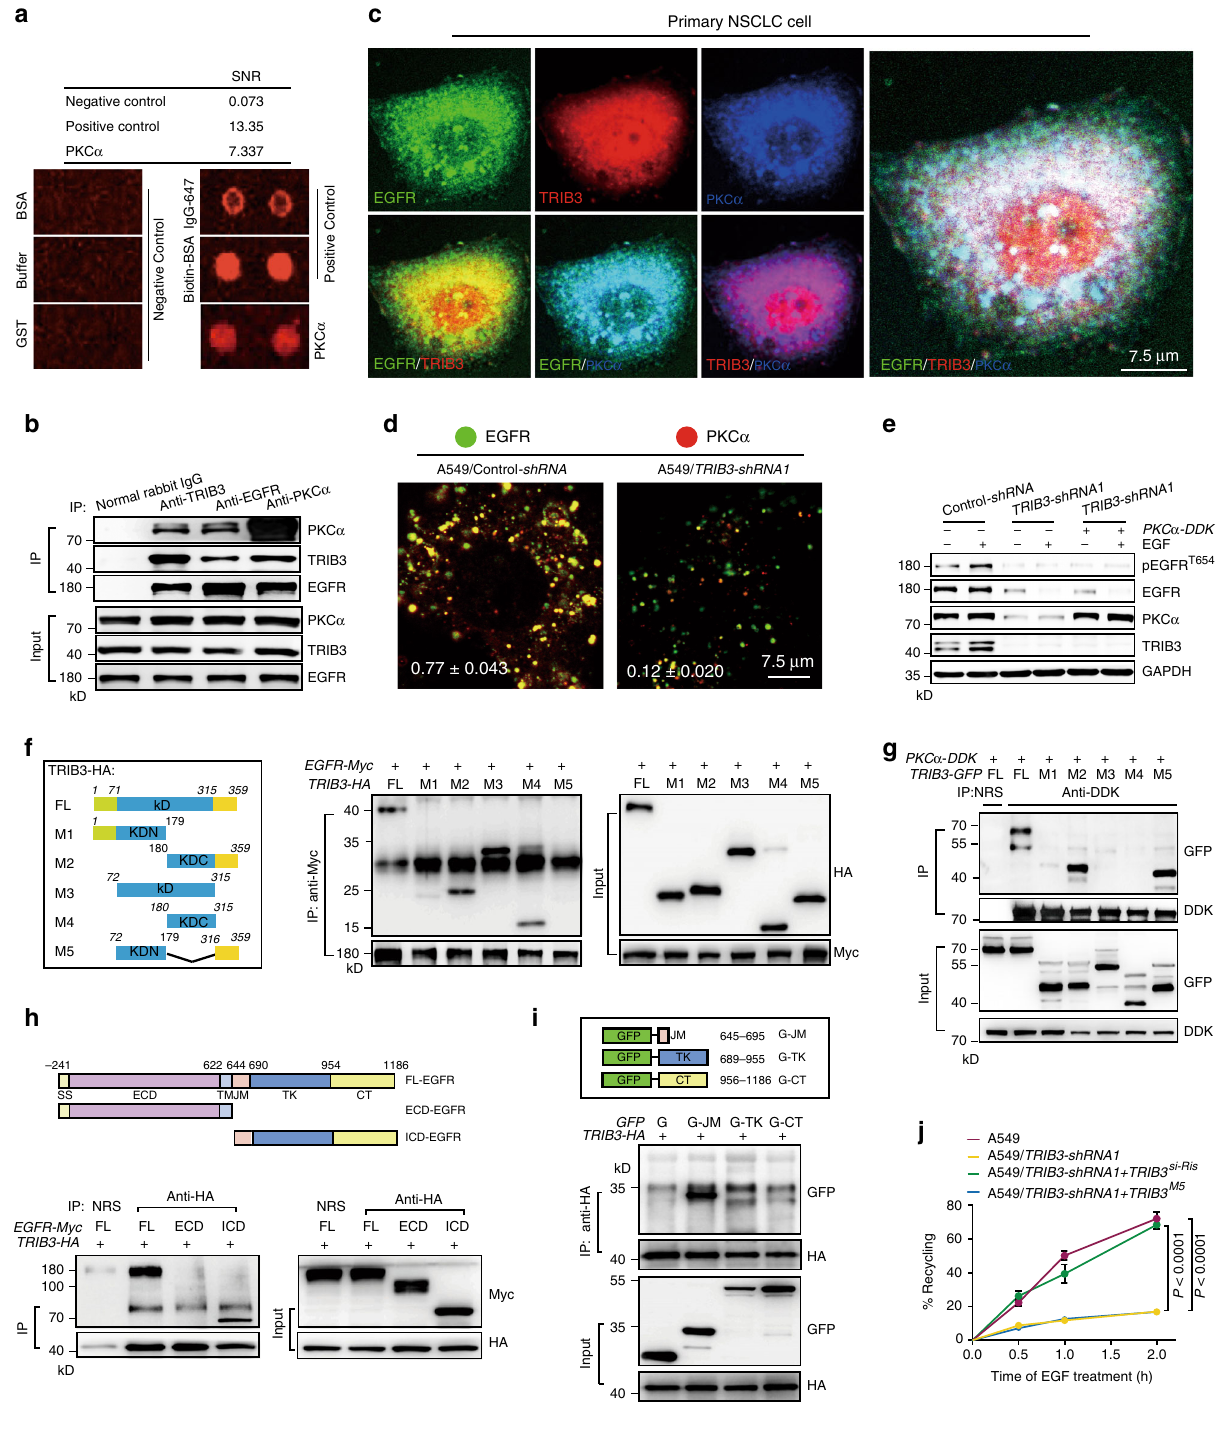
and WWP1-regulated EGFR stability. Cancer stem cells (CSCs) are considered as the root of tumor relapse and resistance 29 . TRIB3 depletion decreased the expression of critical CSC markers (Supplementary Fig. 4e), as well as their target gene sets (Supplementary Fig. 4f). Indeed, depletion of either PKC α or WWP1 abrogated TRIB3-enhanced tumor sphere formation (Fig. 5i); while TRIB3 depletion-impaired tumor sphere forma- tion could be rescued by overexpressing the of EGFR T654D mutant but not the EGFR T654A or EGFR T654D/K689R mutants (Supplementary Fig. 4g). These data suggest that TRIB3, PKC α